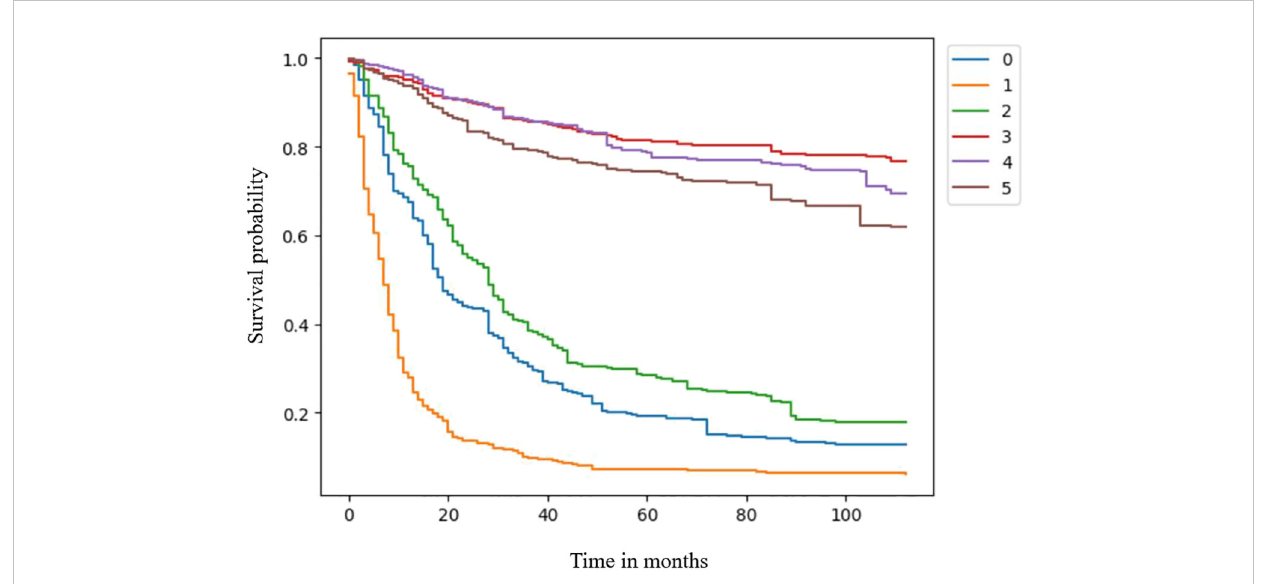
FIGURE 2 Survival curves for the surgery and non-surgery